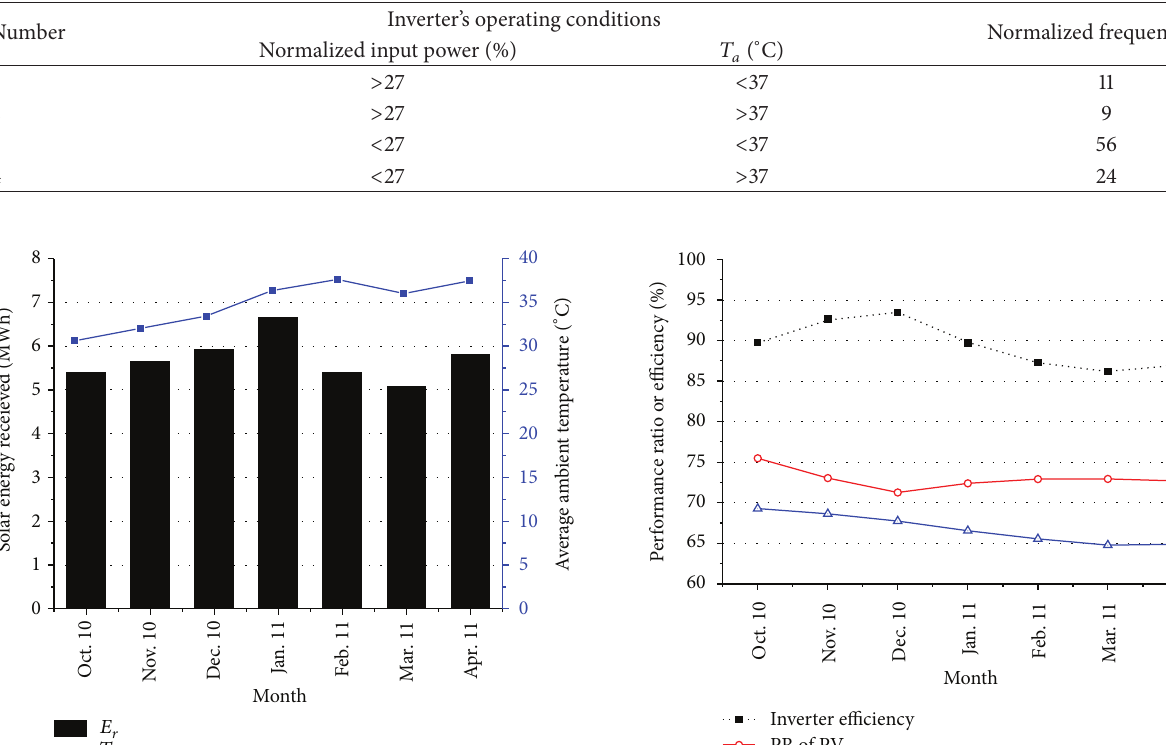
Table 2: Normalized frequency distributions of four different inverter’s operating conditions.